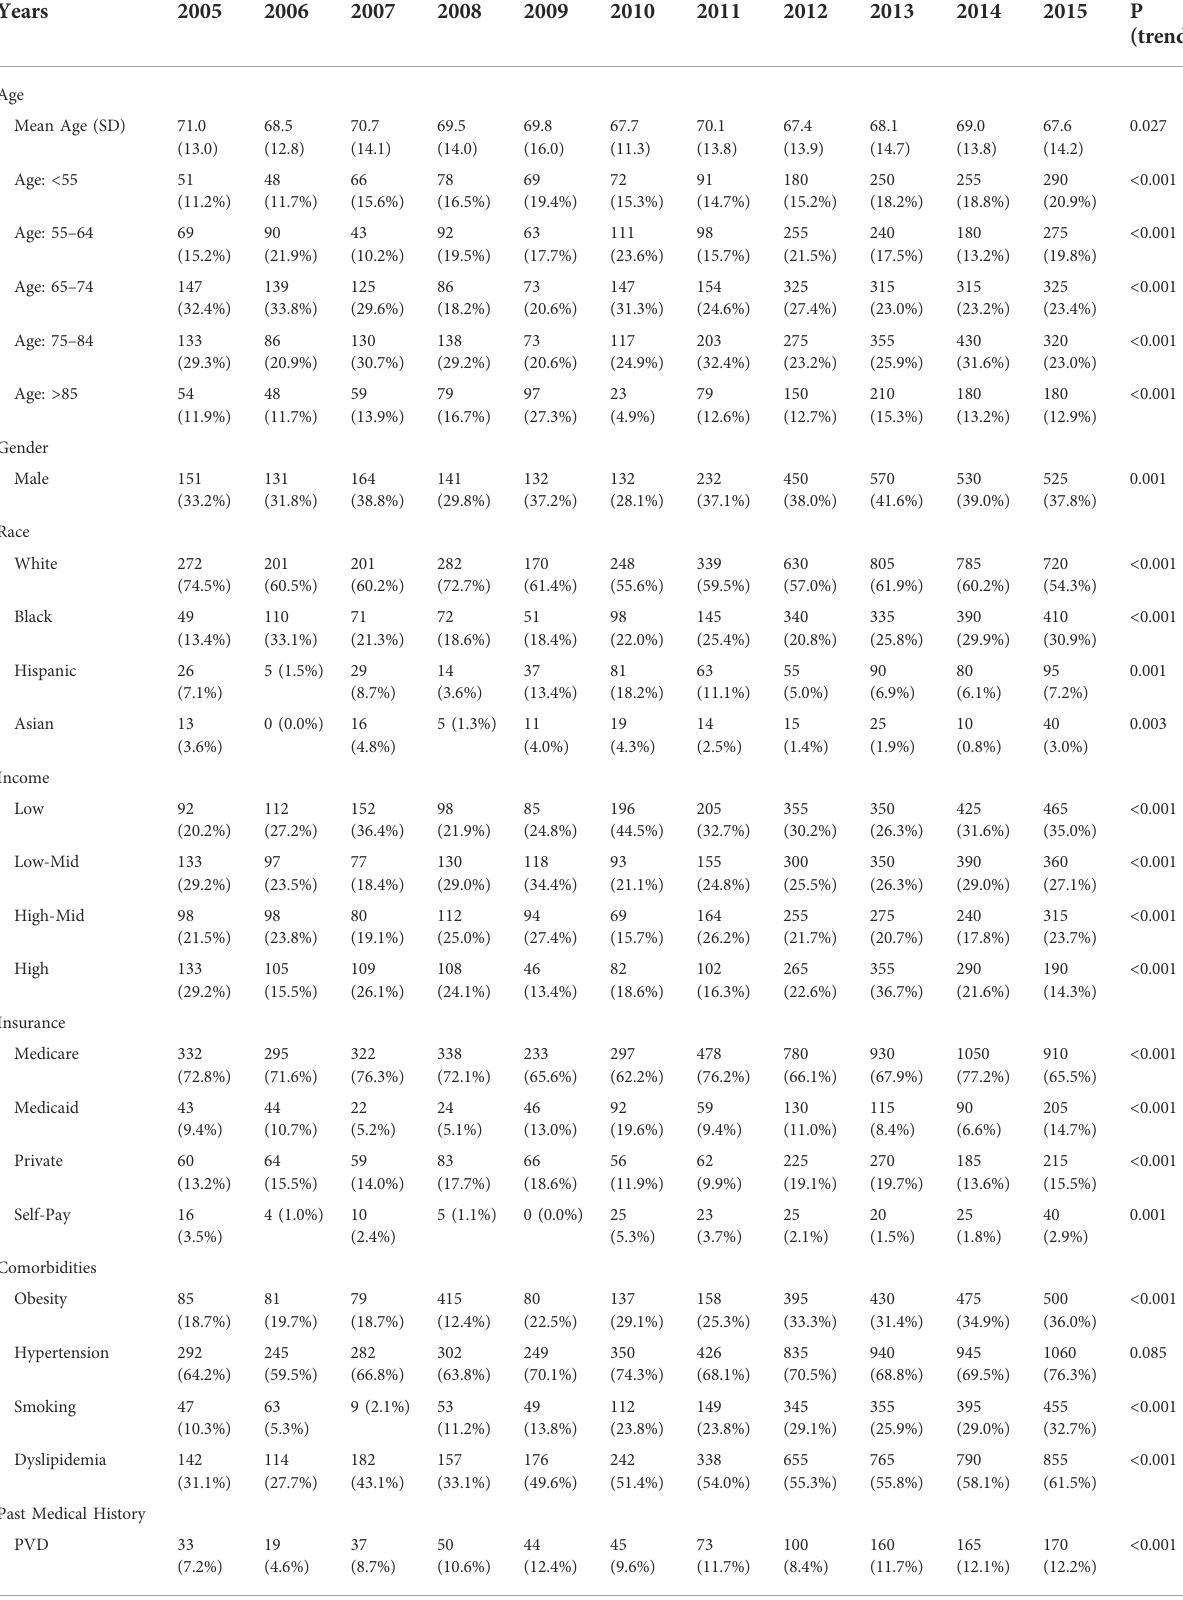
TABLE 1 Baseline characteristics and temporal trends of diabetes patients with heart failure and hypertrophic cardiomyopathy, from 2005 to